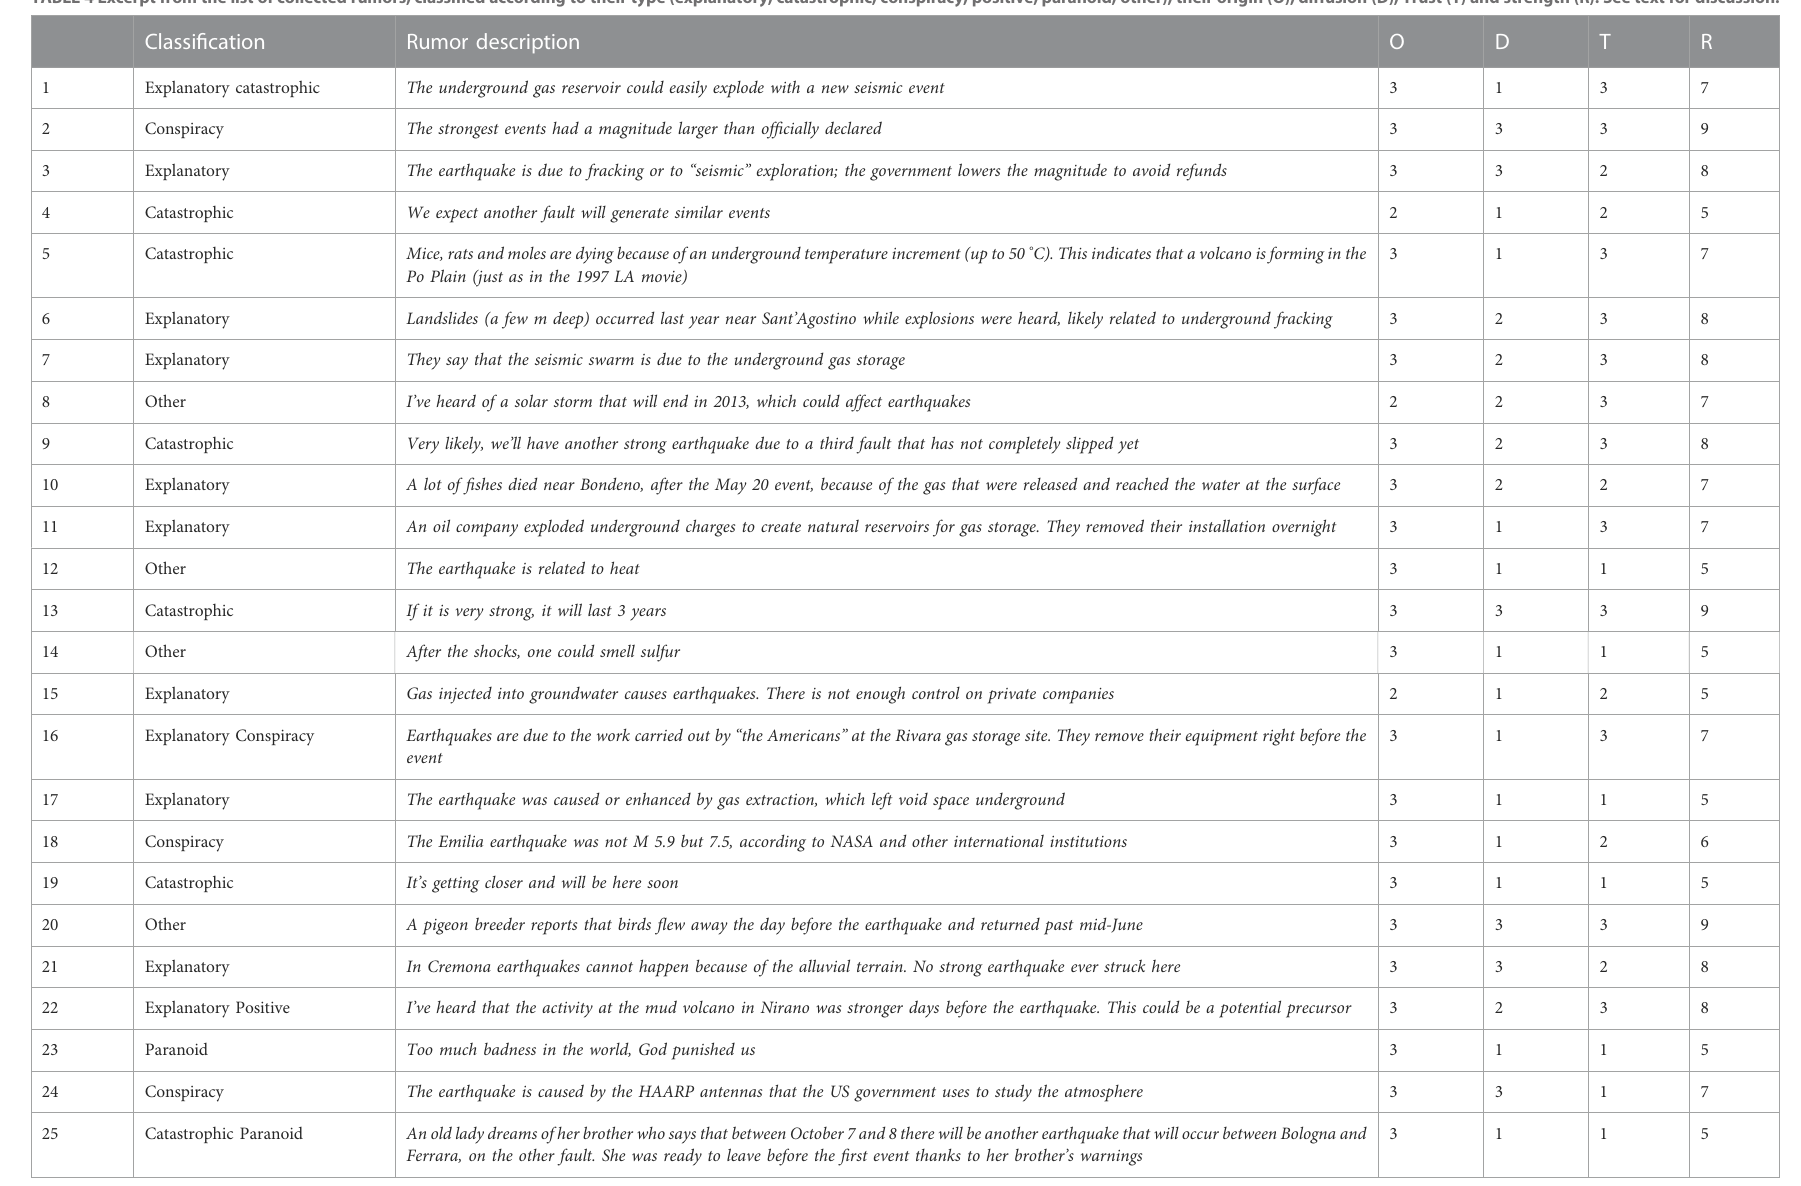
TABLE 4Excerpt from the list of collected rumors, classi fi ed according to their type (explanatory, catastrophic, conspiracy, positive, paranoid, other); their origin (O);diffusion (D), Trust (T) and strength (R). See text for